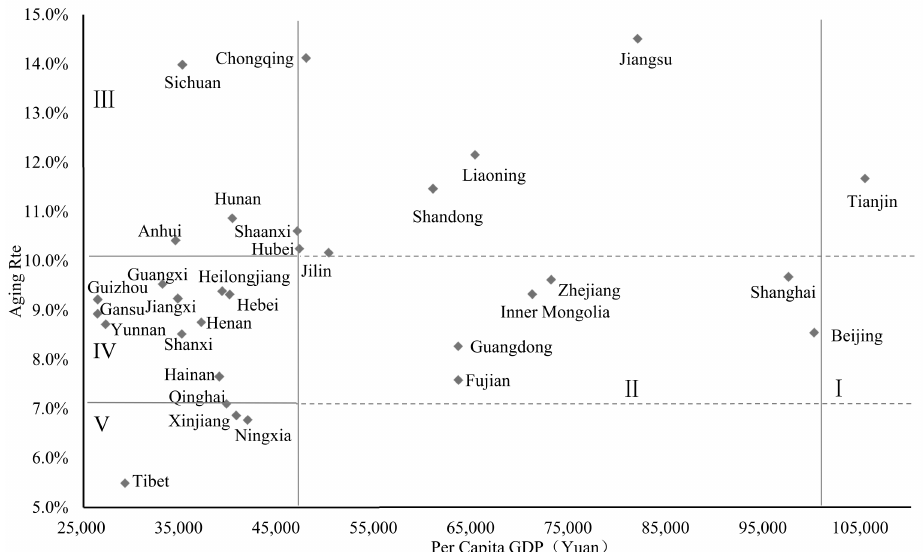
Figure 1. Classification of provincial economic development and population